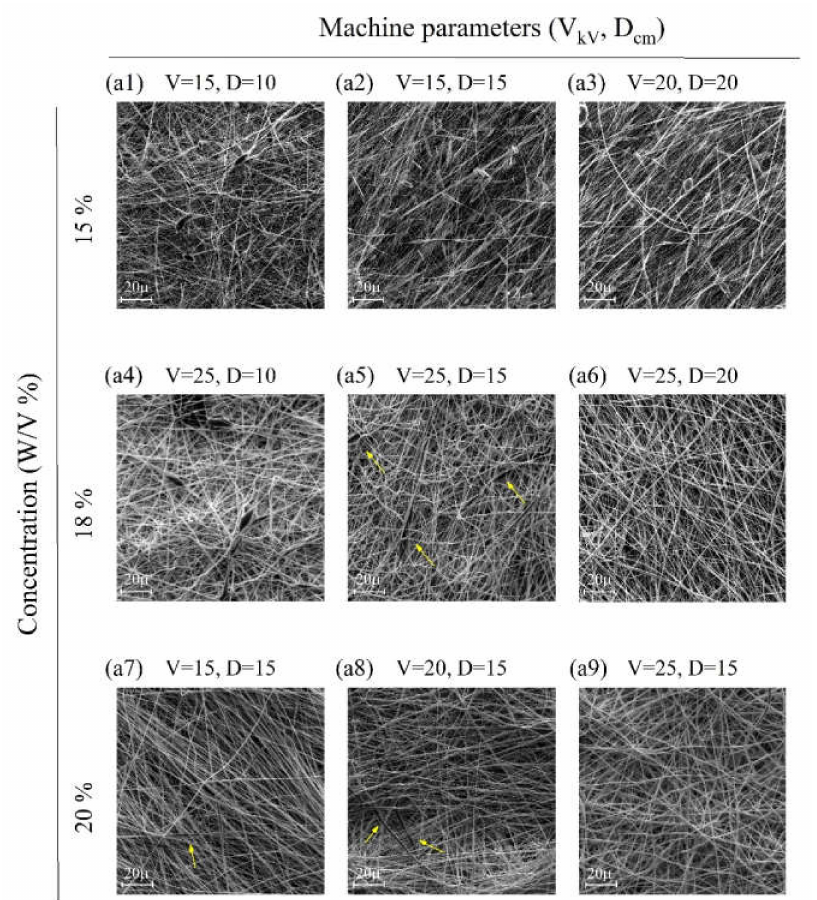
Figure 1. ( a1 – a9 ) SEM images showing the morphology of as-spun polycaprolactone (PCL) fibrous mats obtained from solutions at di ff erent concentrations and various machine parameters (V and D) (arrows show some beads have formed in